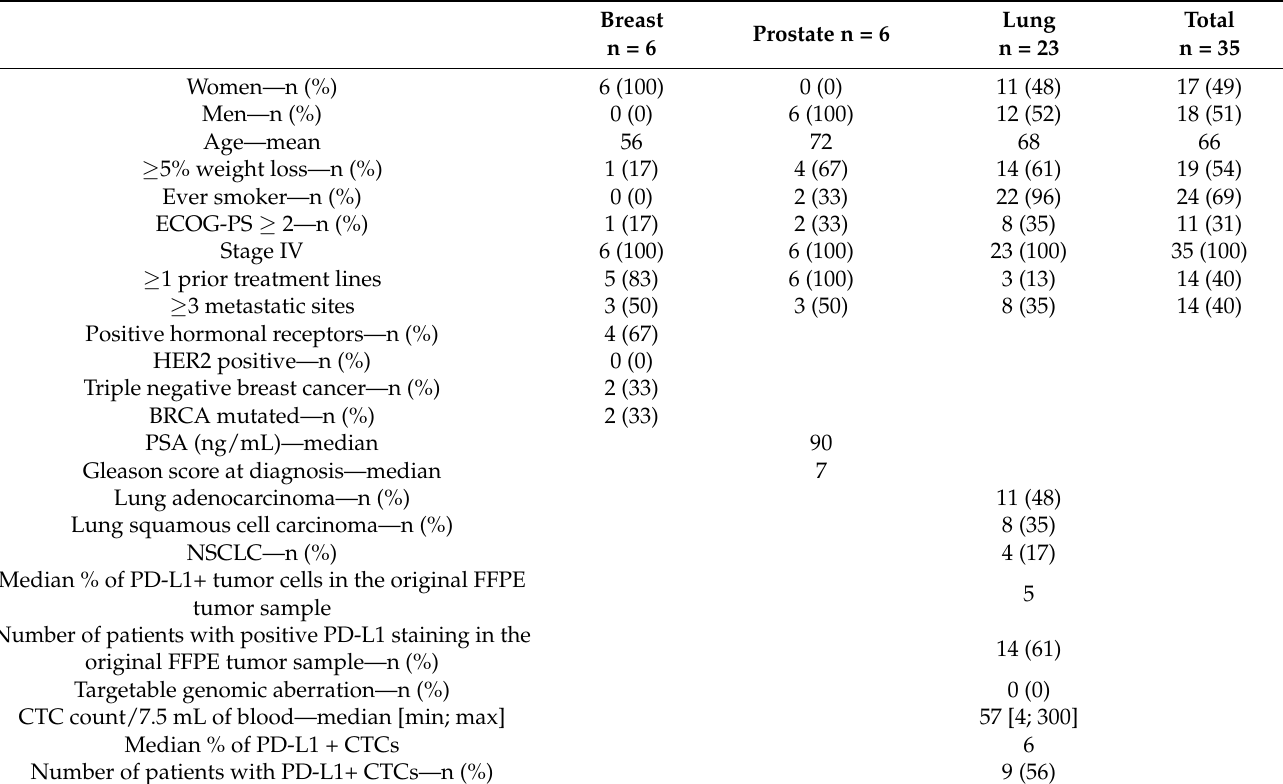
Table 1. Clinicopathological characteristics of the study